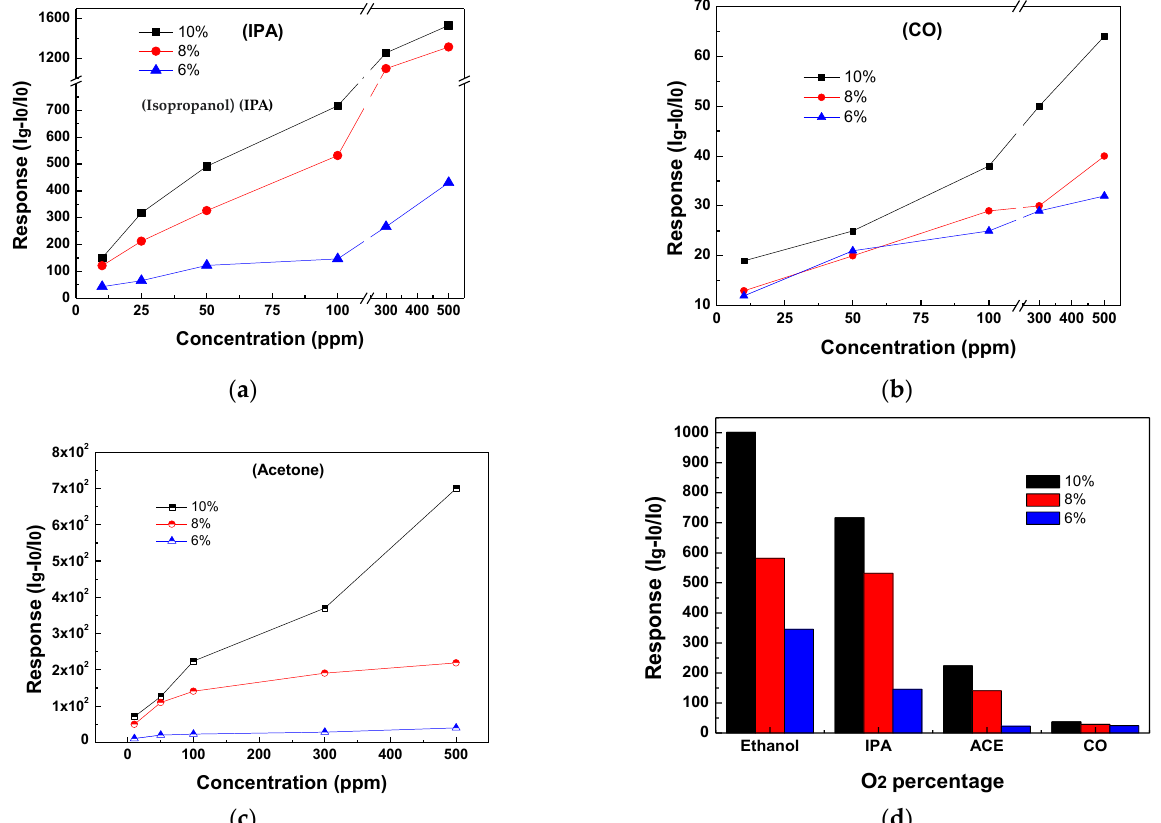
Figure 7. Comparative sensing behavior (300 °C) in response to different oxygen flow percentages as a function of ( a ) isopropanol (IPA), ( b ) CO, and ( c ) acetone concentration. ( d ) Responses of 100 ppm different gases exposed to 10%, 8%, 6% samples.